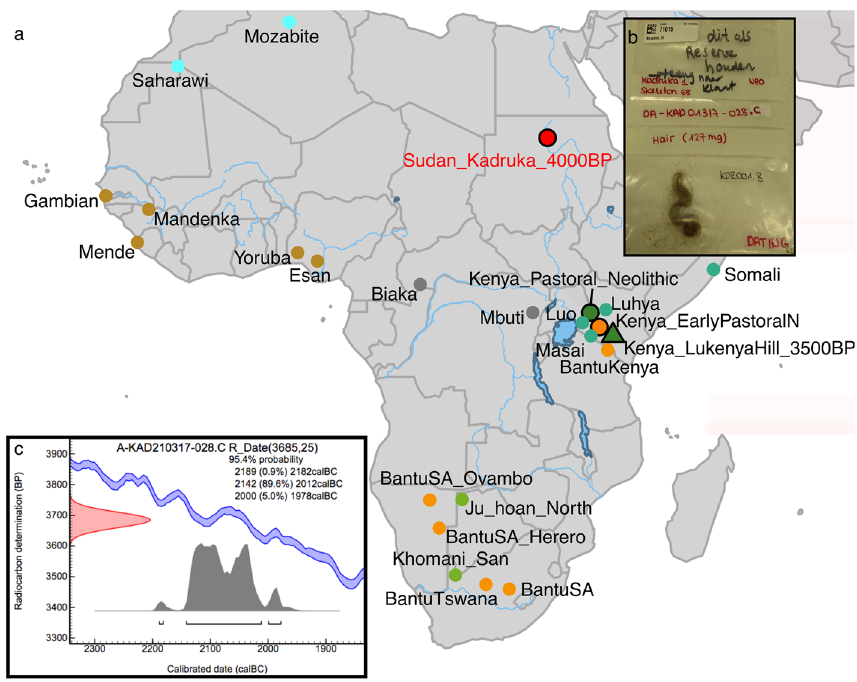
Figure 1. Sample details of the 4,000-year-old hair from Sudan. ( a ) Geographic location of Kadruka and modern African populations used for subsequent analyses. ( b ) Picture of the Kadruka hair sample. ( c ) C14